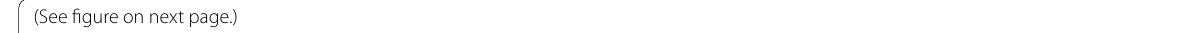
Fig. 2 a Kaplan–Meier analysis of glycan fragments in cancer region. Blue lines indicate survival in patients with high intensity of the respective mass. Red lines indicate survival in patients with low intensity of the respective mass. Example Kaplan–Meier curves of 4 good prognosis and 4 poor prognosis glycan masses in cancer cell region are shown. In the upper panel, a high abundance of Hex‑HexNAcS ( m / z 462.0937), Hex‑HexNAcS‑HexNAc ( m / z 665.1725), dHex‑HexS ( m / z 405.0710) and NeuAc‑Hex‑HexNAcP ( m / z 753.1975) in cancer cell regions was associated with good prognosis. In contrast, in lower panel, high abundance of HexA ( m / z 193.0350), chondroitin/hyaluronan ( m / z 378.1050), dHex‑Hex‑HexAMe ( m / z 515.1625) and ( m / z 599.1955) HexNAc‑HexA‑HexNAc was associated with poor patient prognosis. b Kaplan–Meier analysis of glycan fragments in the stroma region. Blue lines indicate survival in patients with high intensity of the respective mass. Red lines indicate survival in patients with low intensity of the respective mass. High abundance of HexS ( m / z 259.0135) in stroma regions was associated with good prognosis. High abundance of HexNAcS ( m / z 282.0290), HexA‑HexNAc ( m / z 396.1150), HexNAcSS ( m / z 401.9785) and HexA‑HexNAcS ( m / z 476.0725) in stroma regions was associated with poor